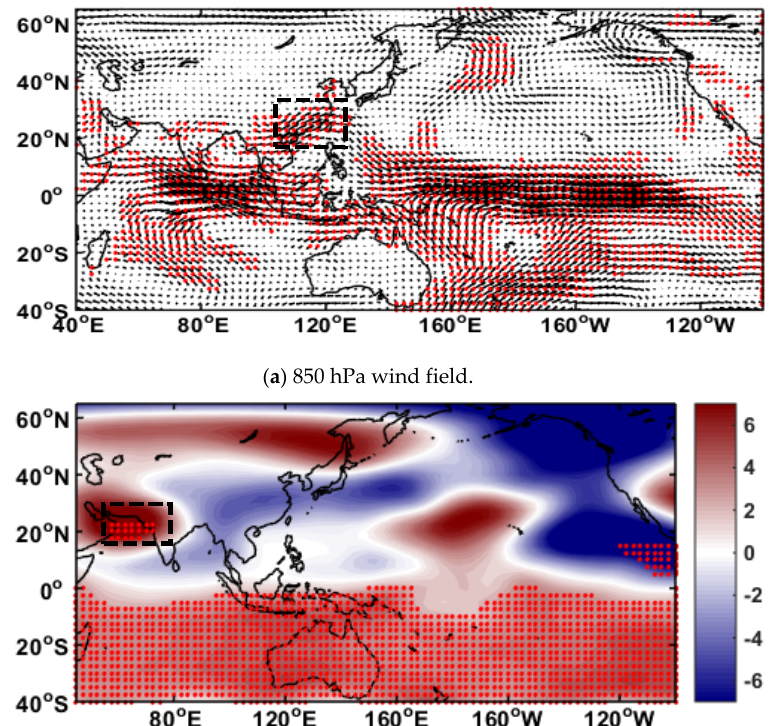
( c ) 700 hPa relative humidity field. Figure 4. Regression maps based on EWI (the marked areas indicate statistically significant values